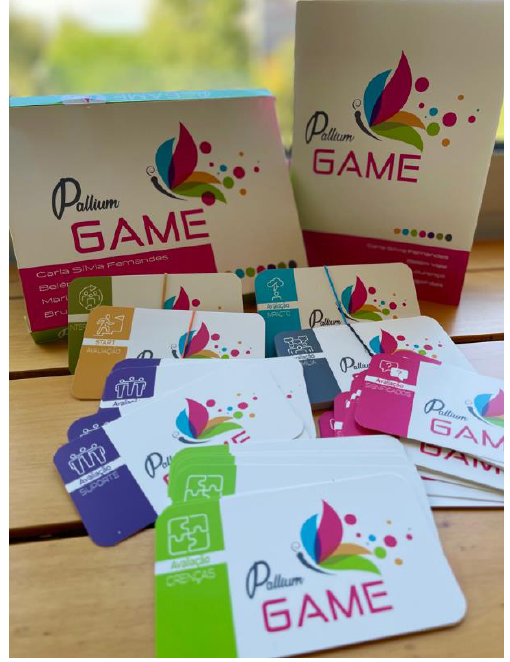
Figure 1. “ Pallium Game ”